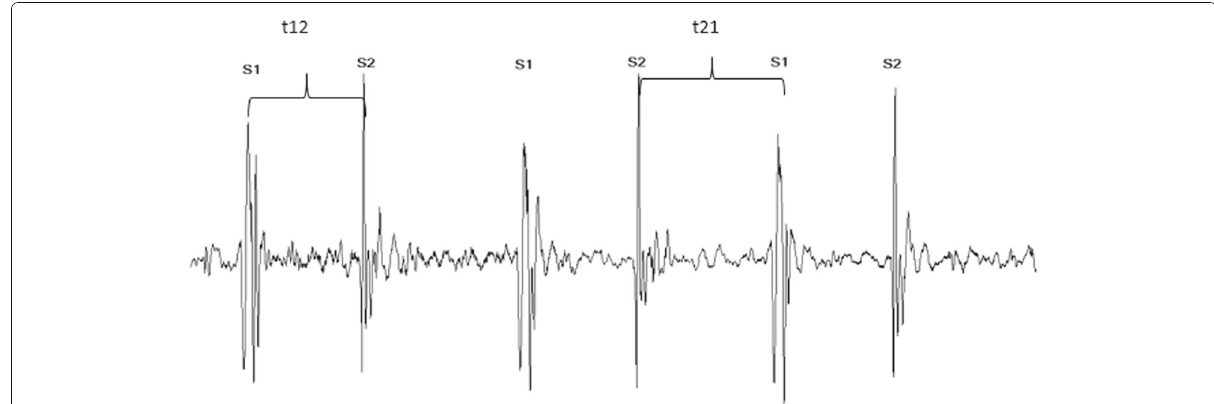
Fig. 2 An example of a PCG signal